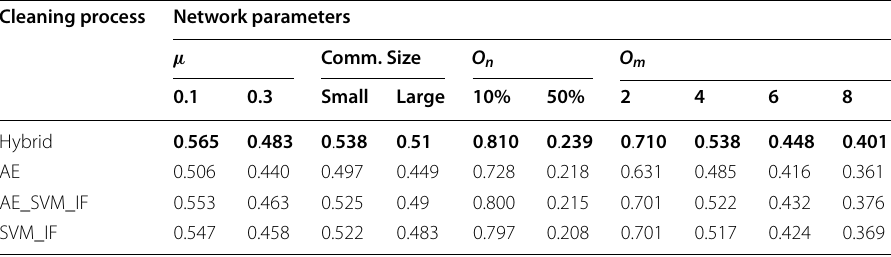
Table 10 Average NMI scores of AC-SLPA achieved using different cleaning processes on small synthetic networks with different network parameters Cleaning process